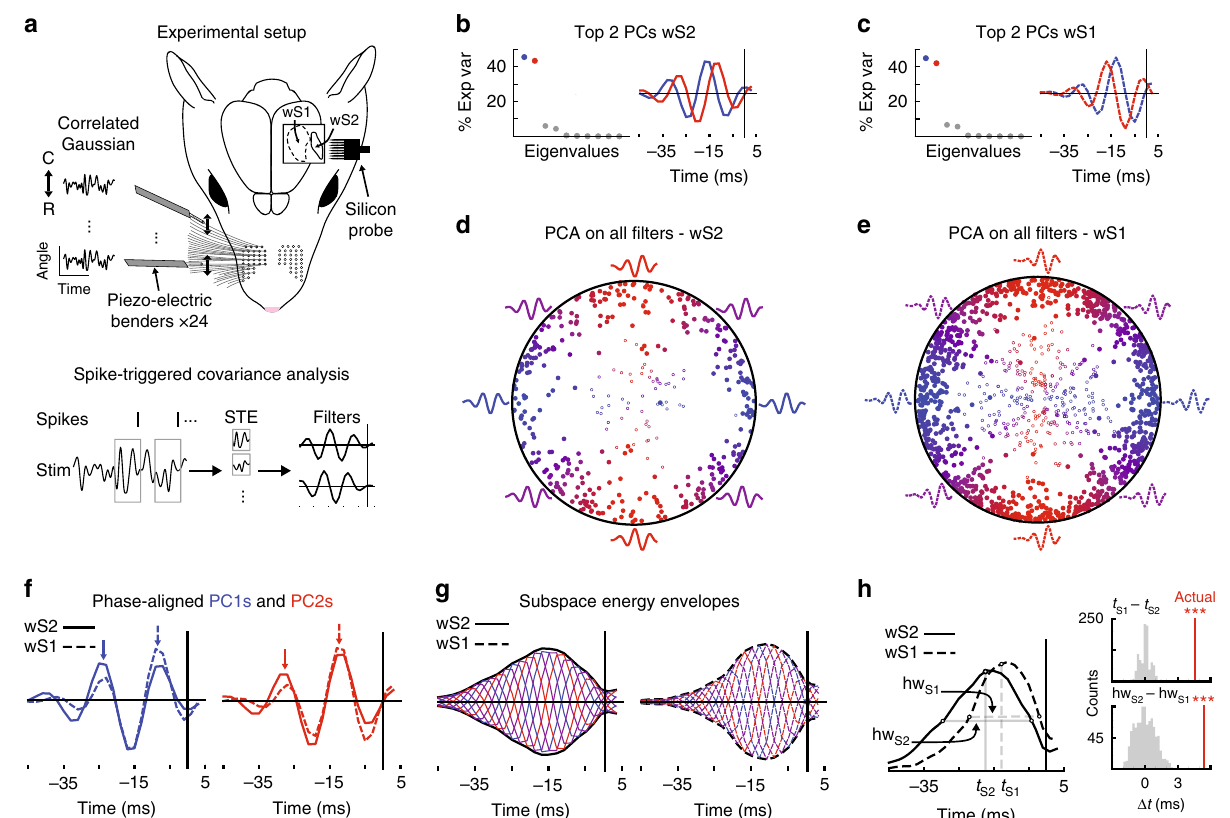
Fig. 1 Extended temporal integration in wS2 during correlated Gaussian white noise stimulation a Recording setup. Top: The right 24 caudal macrovibrissae of iso fl urane-anesthetized rats are trimmed and placed inside plastic tips attached to piezo-electric benders. Only two stimulators are shown, each controlling whisker movements along the rostral-caudal (R-C) axis. All whiskers received the same Gaussian white noise de fl ections (in position).